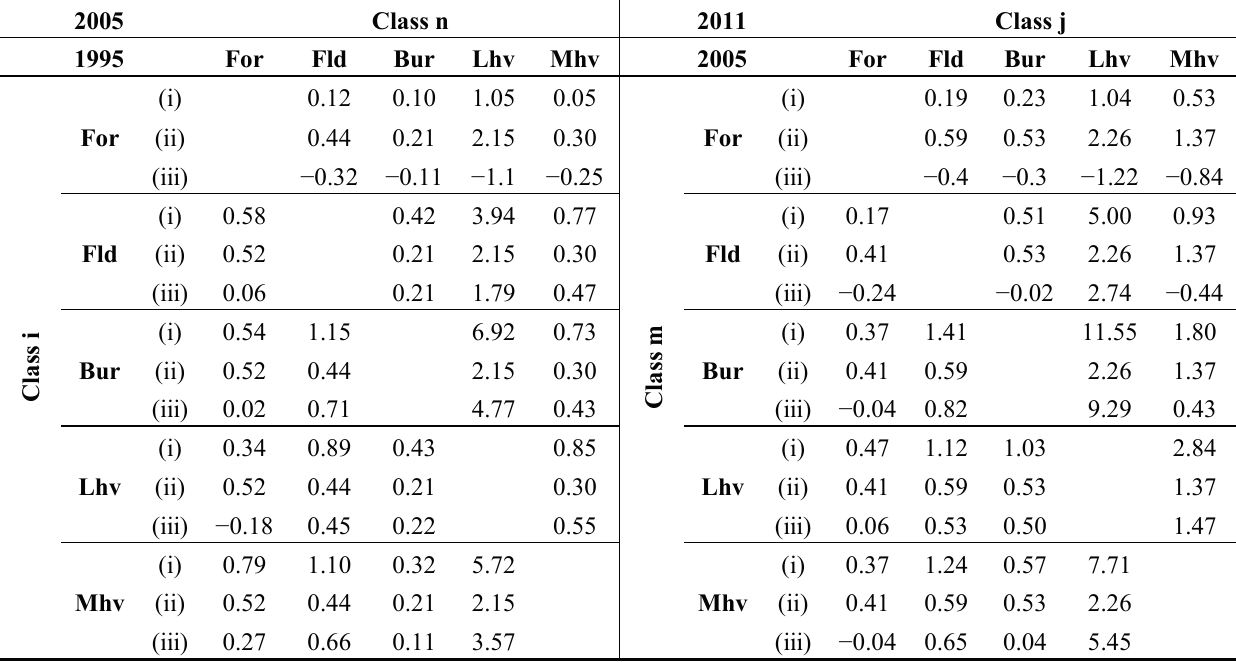
LC classes: For=Forest, Fld = Flooded vegetation, Bur = Burnt plots, Lhv = Low-height vegetation, Mhv = Medium-height